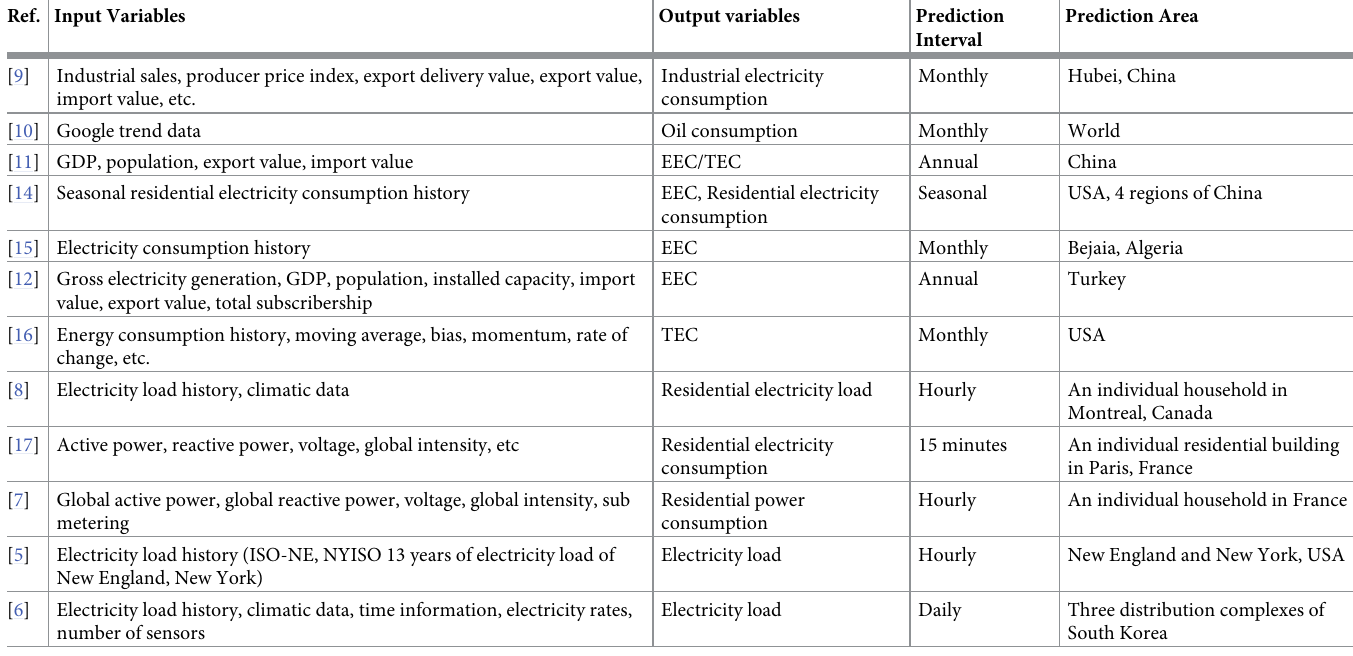
Table 2. Some typical types of energy forecasting